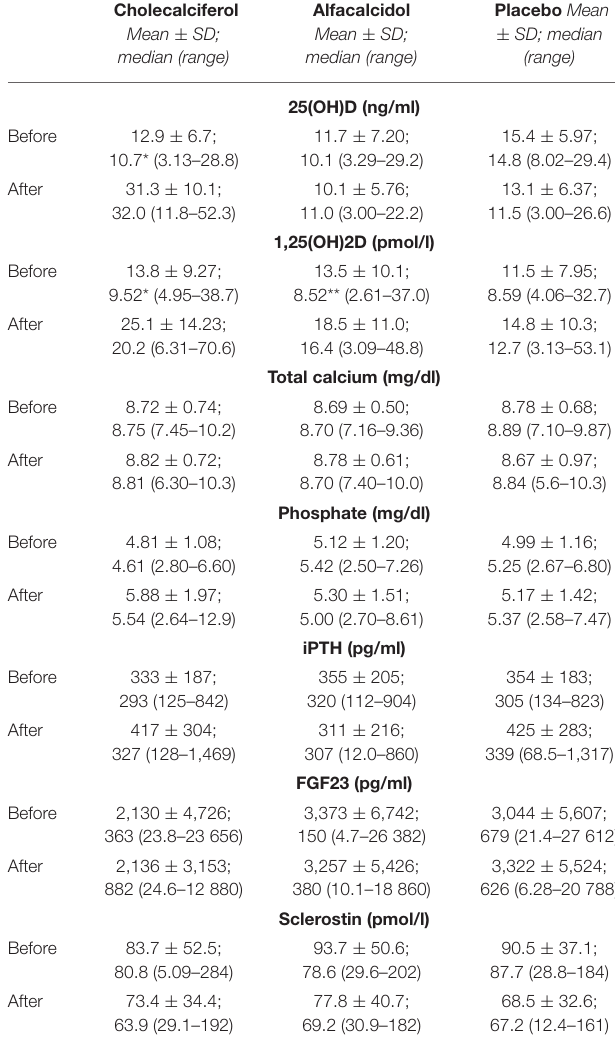
TABLE 2 | Changes in biochemical parameters during the treatment in three studied